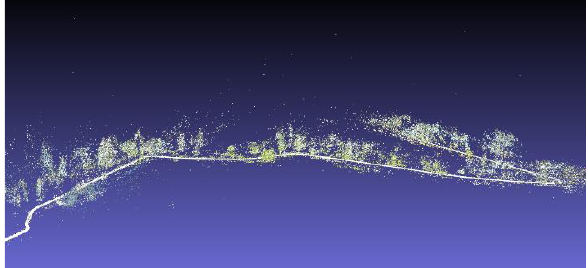
Figure 10. Sparse visual-inertial odometry